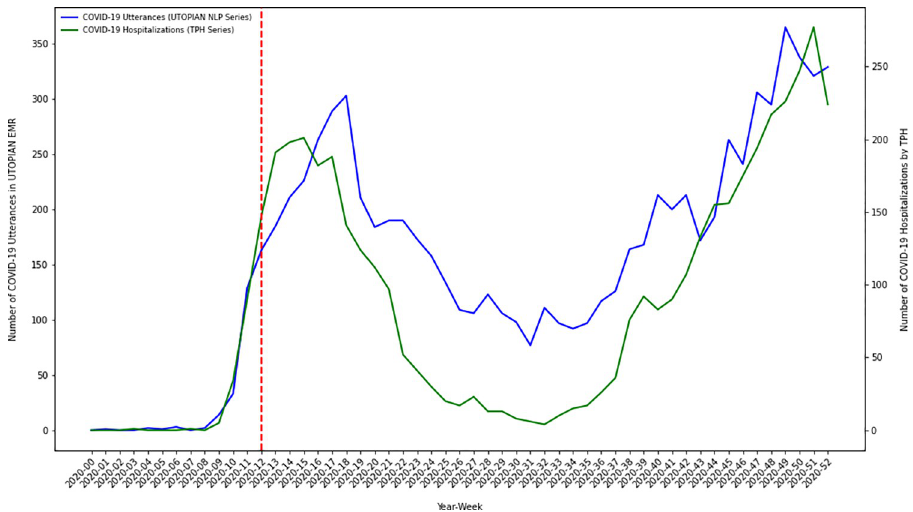
Fig 2. Time series plot of the composite count of the number of COVID-19 positive utterances from each of the three electronic medical record text streams (lab text, health condition diagnosis text and clinical notes) versus the number of COVID-19 related hospital admissions in Toronto, Canada (data extracted from Toronto Public Health). https://doi.org/10.1371/journal.pdig.0000150.g002 concordant. Spearman correlation coefficients between the primary care text-based indicator series and the Toronto Public Health indicator series were strong (results not shown). How- ever, when we conducted cross-correlation function analyses between the ARMA(1,1) differ- enced residual series we did not observe the primary care text-based indicator series as being a consistent leading/lagging indicator of any of the Toronto Public Health indicator series (results not shown). Future work will continue to examine whether for particular COVID-19 waves (subject to particular public health interventions) the primary care text-based series was a leading/lagging indicator of particular public health outcomes.